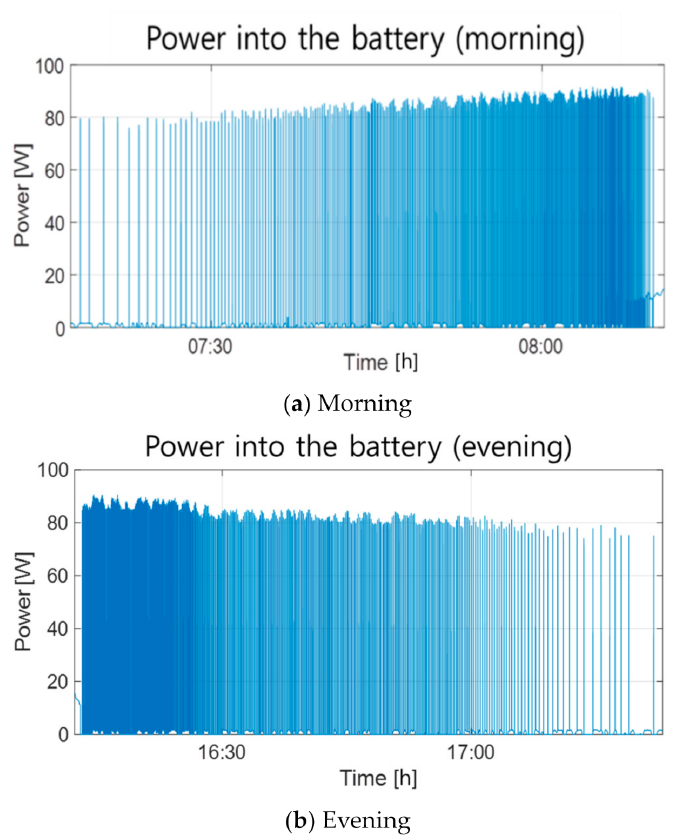
Figure 11. Battery Power in the morning and the evening. ( a ) shows the capacitors operating in the morning. ( b ) shows the capacitors operating in the